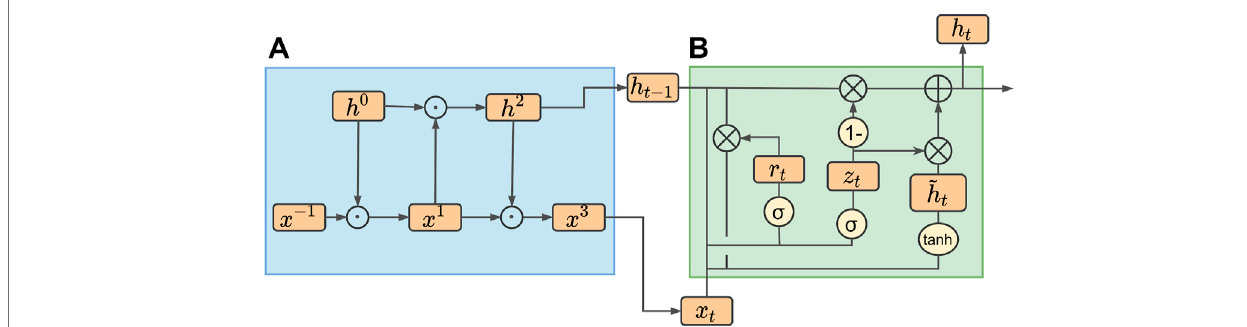
FIGURE 4 | IMgru model structure. (A) IM module. (B) GRU module.